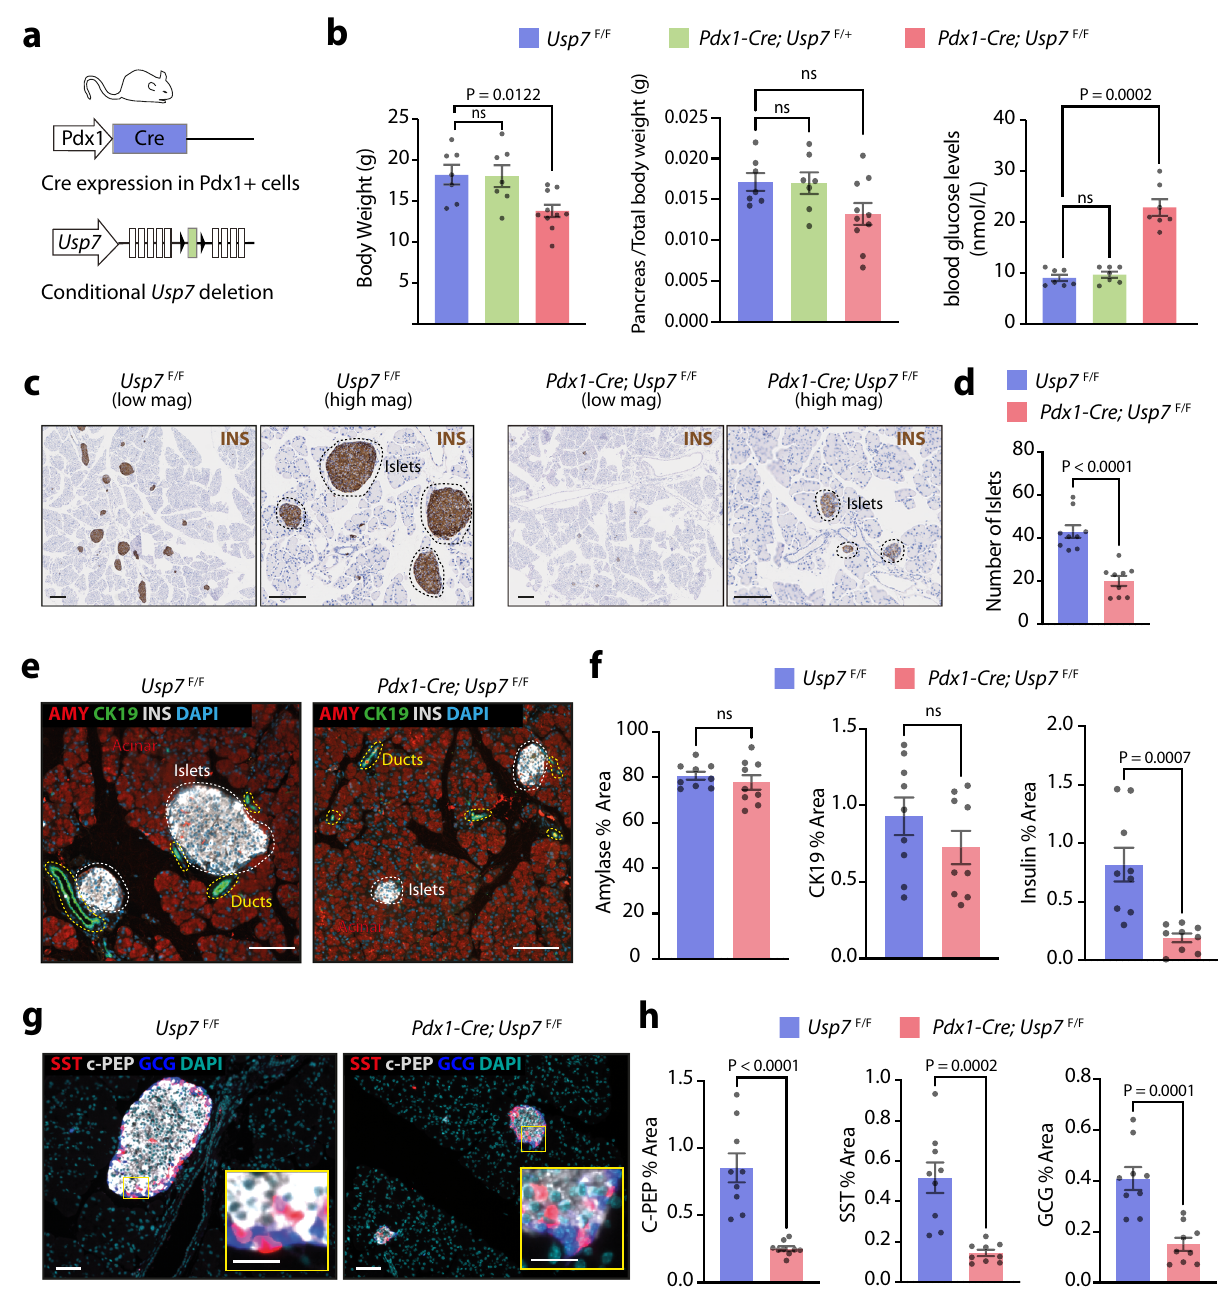
Fig. 3 | USP7 deletion in the pancreas leads to reduced Islet formation and endocrine lineage cell differentiation. a Schematic of pancreatic-speci fi c Usp7 knockout mouse. Thisdiagram is adapted from ref.56Fig.2a underPublicLicense CC BY 4.0 (https://creativecommons.org/licenses/by/4.0/legalcode). b In 5 – 8- week-old mice, whole body weight, pancreas weight/total body weight ratio, and circulating blood glucose concentrations were measured in the indicated murine strains. The bar graph represents mean±SEM and statistical signi fi cance was determined by one-way ANOVA with Dunnett post hoc test ( n =7 biologically independentanimalspergroup,exceptforthe Pdx1-Cre;Usp7 F/F group,wherebody weight and pancreas/total body weight was measured in ten animals). c Immunohistochemical analysis of Insulin (INS) expression in Usp7 wild-type ( Usp7 F/F ) and knock-out ( Pdx1-Cre; Usp7 F/F ) pancreatic tissues. The scale bar is 200 µ m in low magni fi cation and 100 µ m in high magni fi cation. d Total number of islets in whole pancreatic sections in Usp7 wild-type and knock-out mice. The bar graphrepresentsmean±SEM,andstatisticalsigni fi cancewasdeterminedbyatwo-